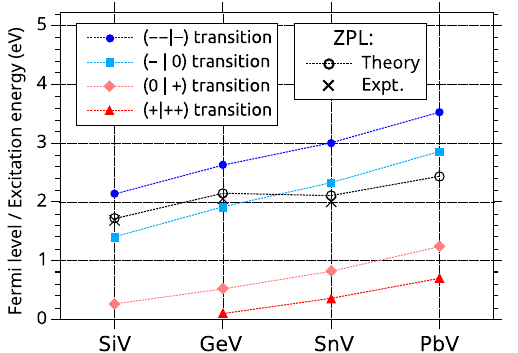
FIG. 2. Adiabatic photoionization of X V defects [see Eq. (1)] and excitation energies for X V ð − Þ centers (see Sec. III B). All the charge transition levels are referenced to the valence band maximum aligned to zero. The conduction band minimum is at 5.4 eV. We note that these energies do not contain spin-orbit energy corrections. See text for explanation. with respect to the valence band maximum. The stability window of the ( − ) state shifts up in the gap with increasing atomic number of the group-IV impurity atom. SnV ð − Þ and PbV ð − Þ can only be stable by providing substitutional nitrogen donors in the diamond sample. The photostability of PbV ð − Þ requires special attention as the ( − ) state can be converted to (0) by illuminating the sample in the visible region, by ∼ 2 . 6 eV, that it is close to its ZPL energy of about 2.4 eV (see Table I). On the other hand, photo- excitation in the visible region may convert the ( − ) state to the ð 2 − Þ charge state for SiV, GeV, and SnV defects. For isolated SiV ð − Þ , ultraviolet (UV) light would be needed to reionize ð 2 − Þ to ( − ) by single photon absorption, which is difficult to realize in experiments. On the other hand, violet and blue illumination can reionize GeV ð 2 − Þ and SnV ð 2 − Þ